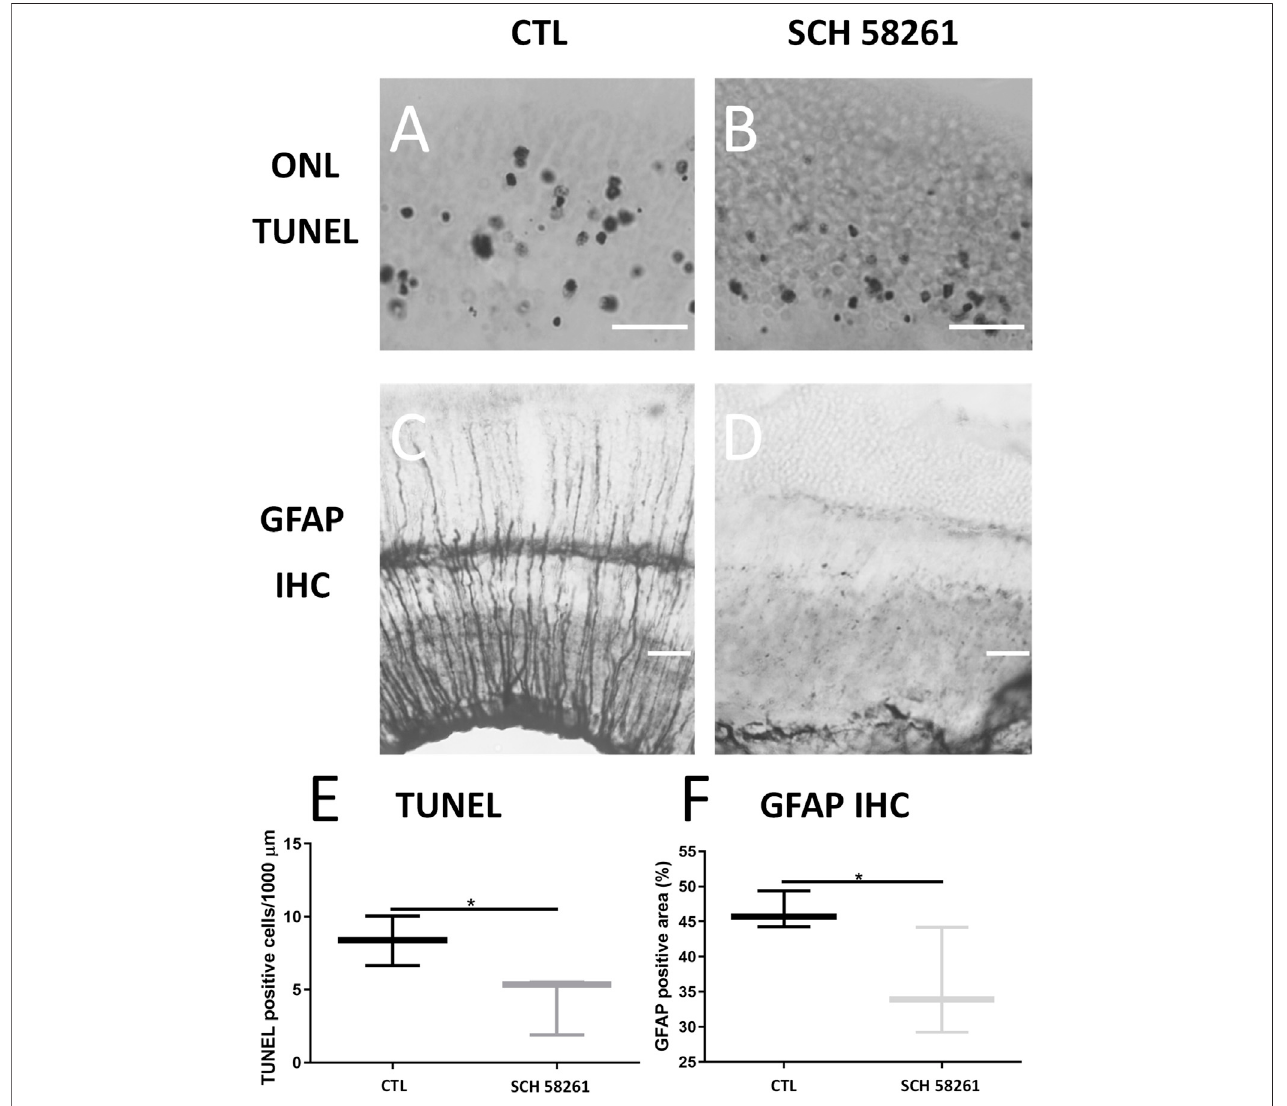
FIGURE 5 | Treatment with SCH58261 decreased number of apoptotic nuclei and GFAP immunoreactive areas. (A,B) Representative section showing TUNEL stainingofONLofretinaofaCTLeye (A) andanSCH58261-treatedeye (B) .Treatedeyeshadalowernumberofapoptoticnucleithancontrols.Scalebar:20 μ m. (C,D) GFAP-immunostained section from retina of a CTL eye (C) and an SCH58261-treated eye (D) . Less GFAP immunoreactivity of Müller cells is observed in retina of SCH58261-treated eye compared with CTL. (E) . Quanti fi cation of TUNEL-positive ONL cells. SCH58261 produced a signi fi cant decrease in number of positive nuclei in ONL compared with CTL. Student ’ s t -test, * p < 0.05. (F) Quanti fi cation of GFAP immunoreactive area. SCH58261 produced a signi fi cant decrease in GFAP expression compared with CTL. Boxes represent 25 and 75 percentiles, whiskers represent minimum and maximum values, and transverse lines represent medians.